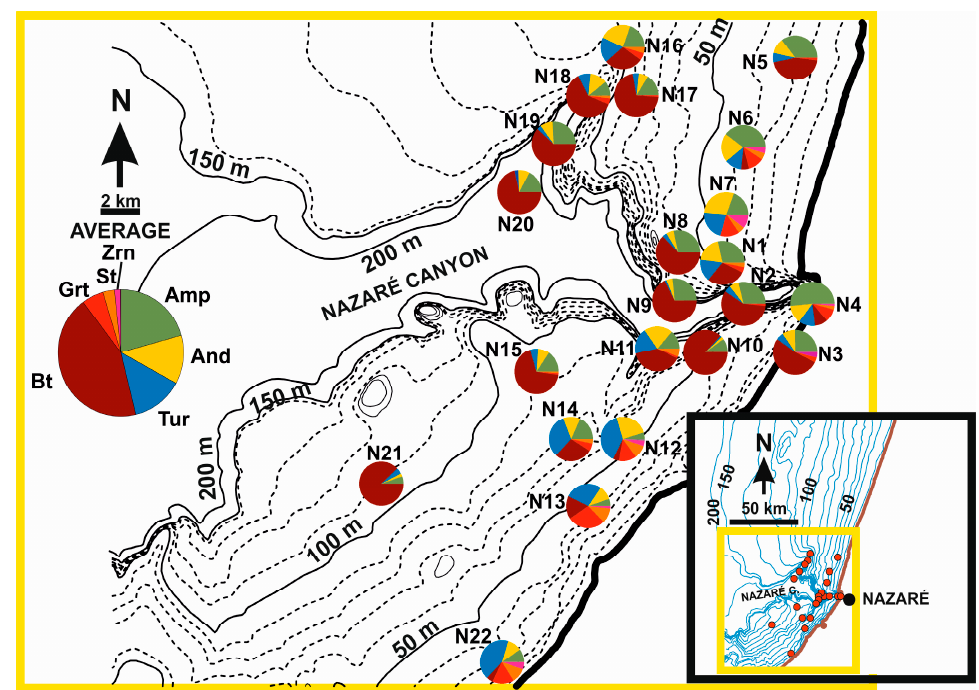
Figure 7. Main heavy mineral suite distribution according to the samples collected from the Nazaré upper canyon area. The average values are represented on the larger pie chart.